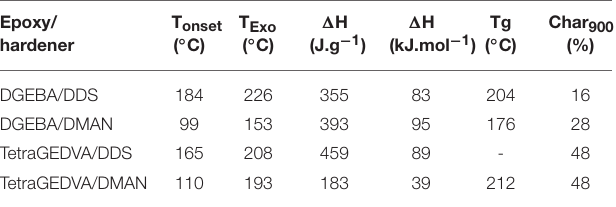
of bio-based epoxy networks, using DSC, showed a weak exothermic peak ( 1 H = 105 J/g for DGEBA/MDVA vs. 430